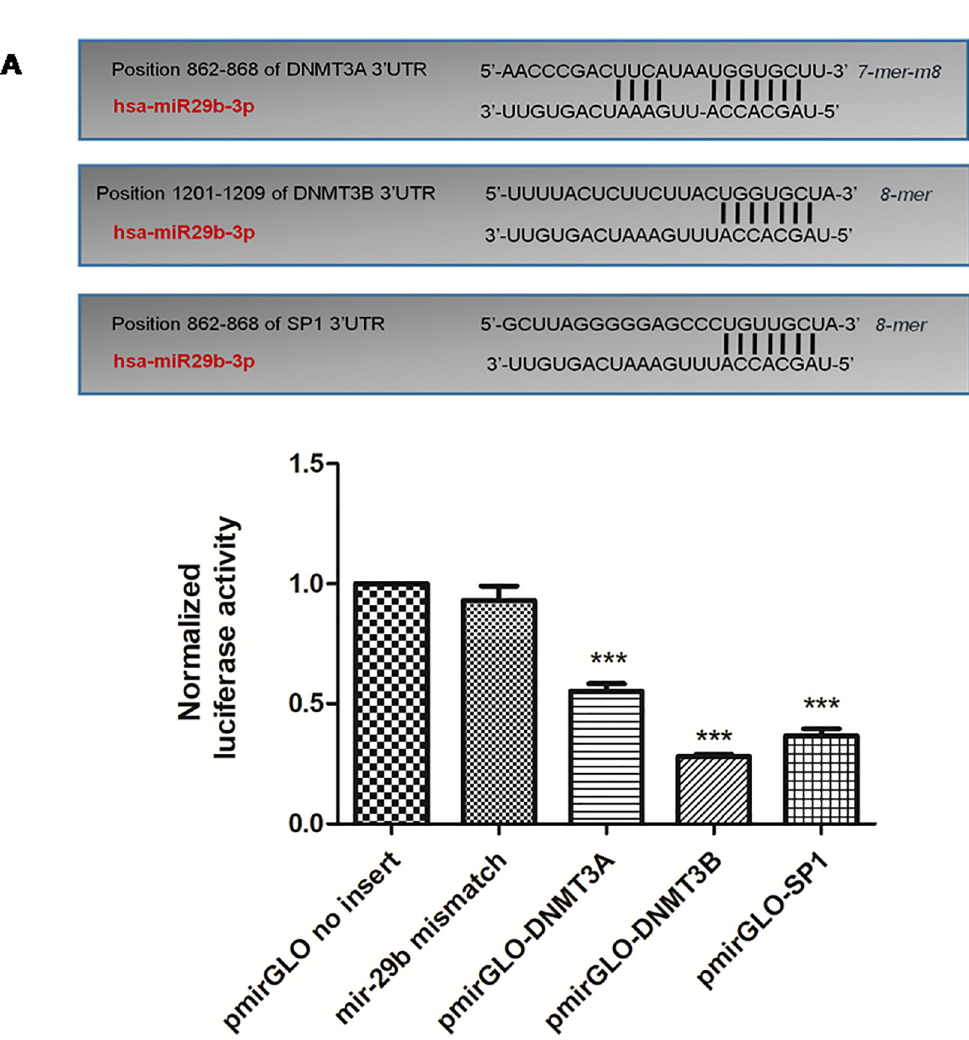
Fig 10. Luciferase activity measurement: The 3’-UTRs of DNMT3A, DNMT3B and SP1 are targets of miR-29b. This figure describes a schematic of binding sites of miR29b with 3’-UTRs of DNMT3A, DNMT3B and SP1. Below is the graphical representation of Dual Luciferase Assay illustrated normalised Luciferase activity of pmirGLO vector (without 3’- UTR insert) and cells transfected with miR29b mismatch sequence (scrambled oligonucleotide). Further, pmirGLO vector with 3 different inserts of DNMT3A, DNMT3B and SP1 were allowed to interact with miR29b mimics independently and their Luciferase activity was examined as shown in this bar graph indicating significant difference in comparison with pmirGLO vector (without insert) and cells transfected with miR29b mismatch sequence ( ��� p <